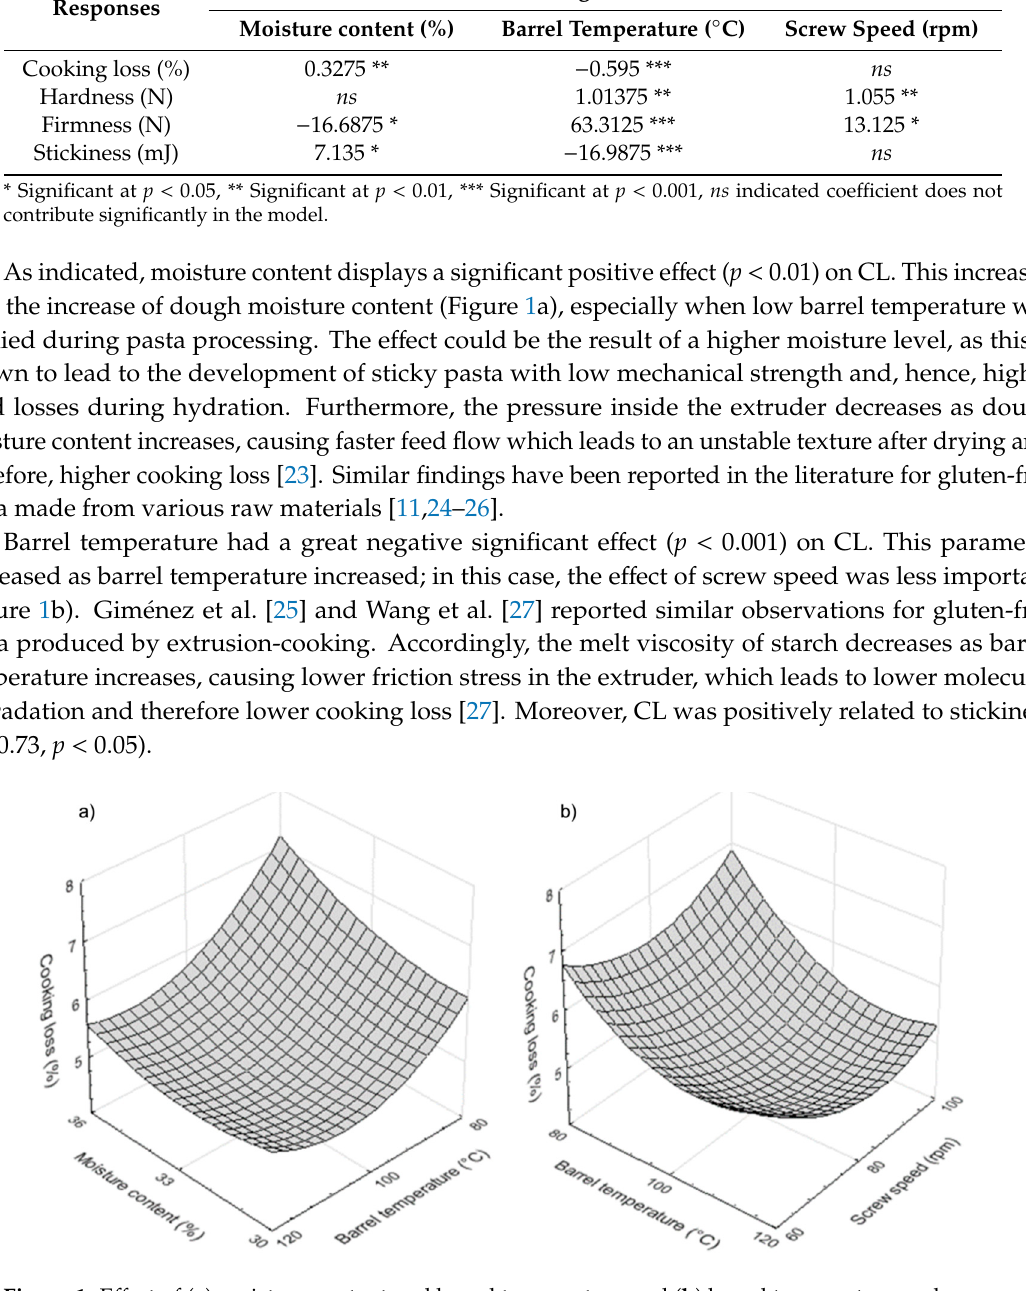
Figure 1. Effect of ( a ) moisture content and barrel temperature and ( b ) barrel temperature and screw speed on cooking loss of rice-buckwheat pasta.